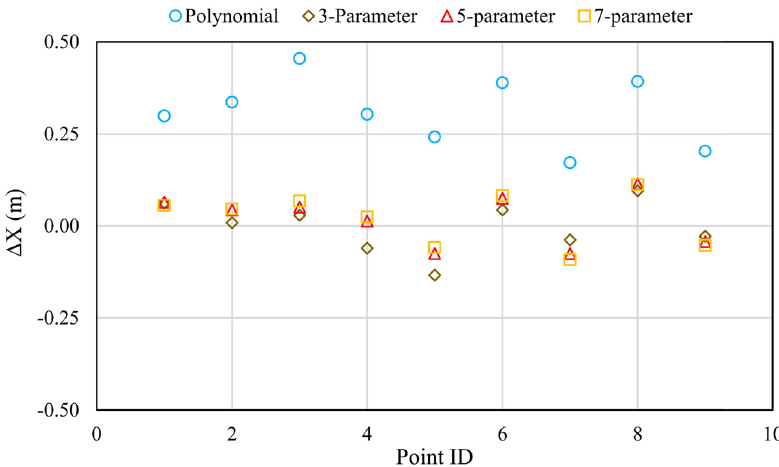
Figure 10: X - coordinate di ff erences between actual and computed values at checkpoints.